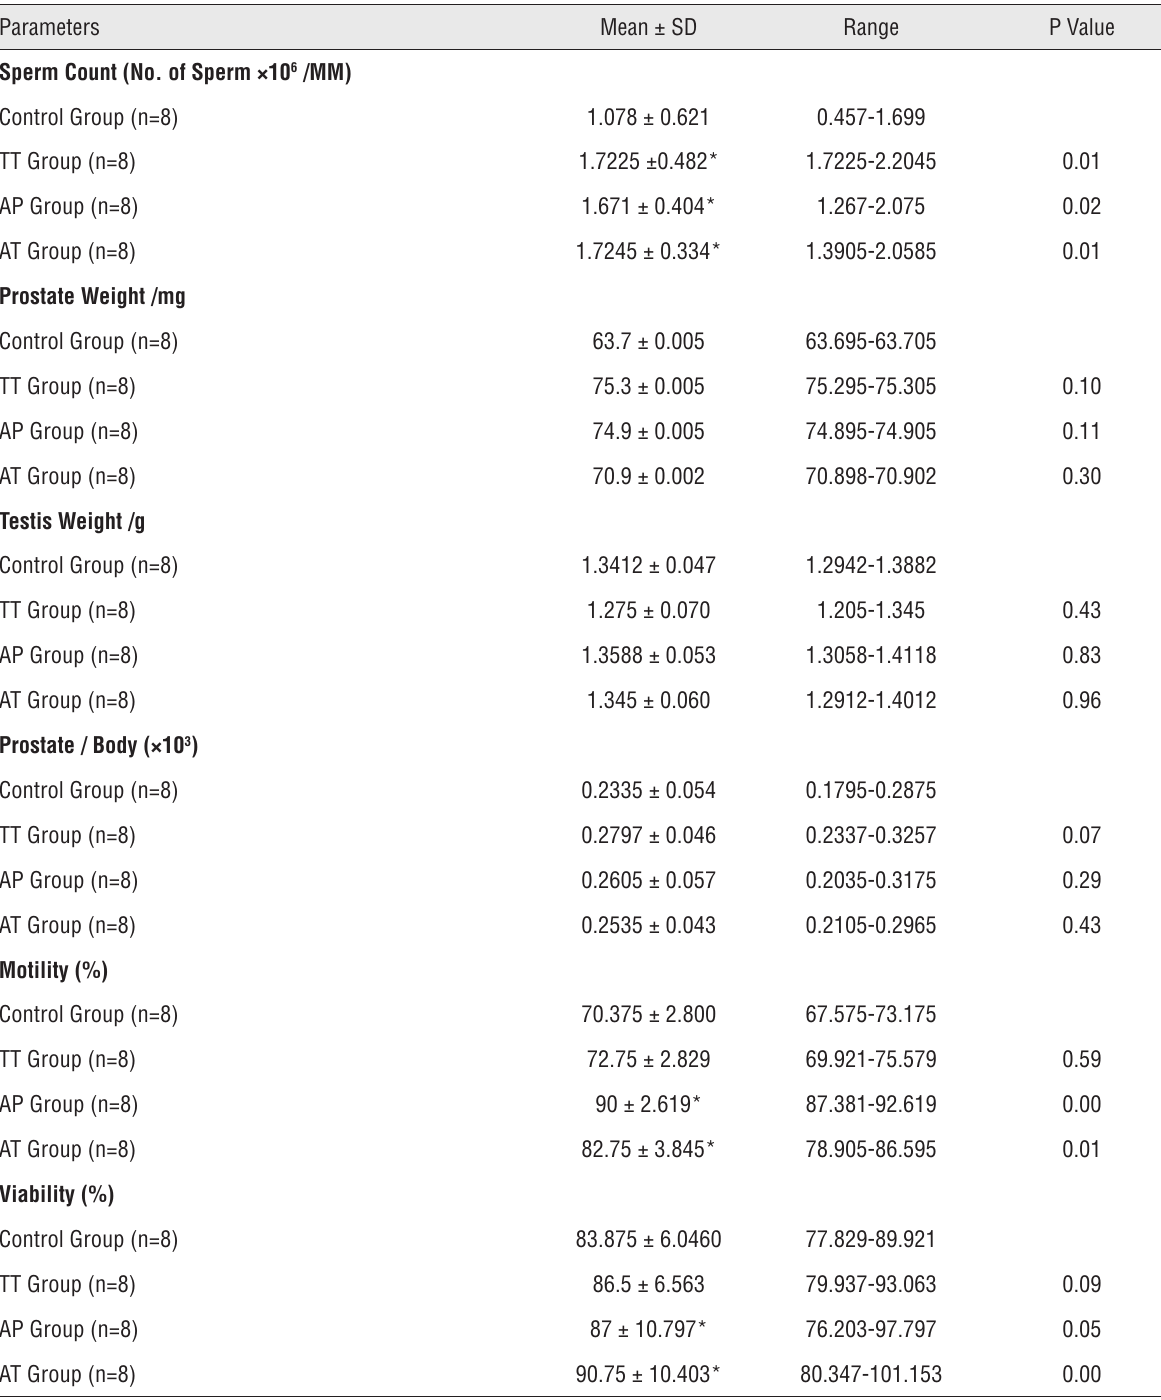
Table 1 - Sexual organ weights and sperm parameters taken in this study (mean ± SD, n=8)